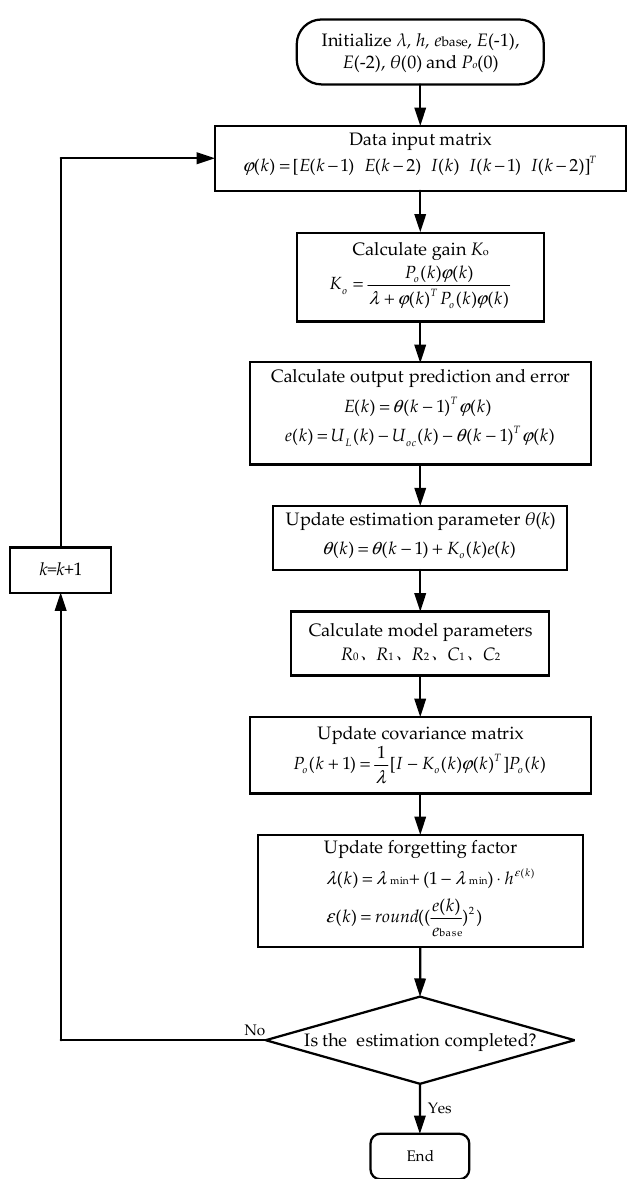
Figure 3. Flow chart of the adaptive forgetting factor recursive least square (AFFRLS)